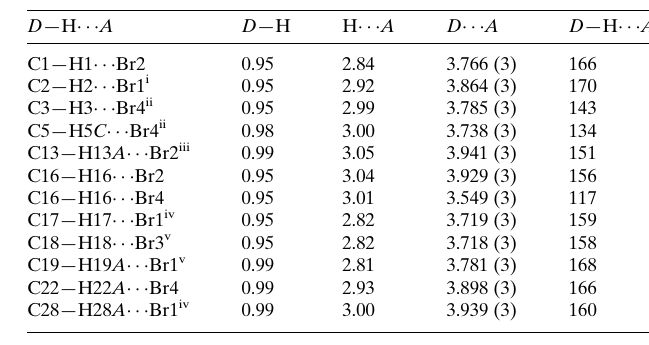
Hydrogen-bond geometry (A˚ , (cid:4)